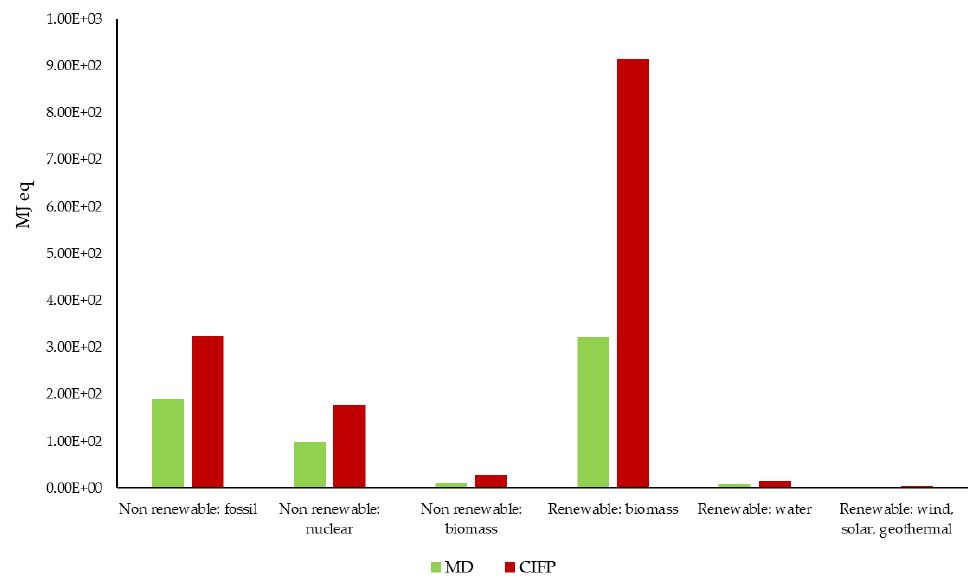
Figure 4. Cumulative energy demand of Mediterranean diet and Italian dietary habits (MD: Mediterranean diet; CIFP: Current Italian food patterns).